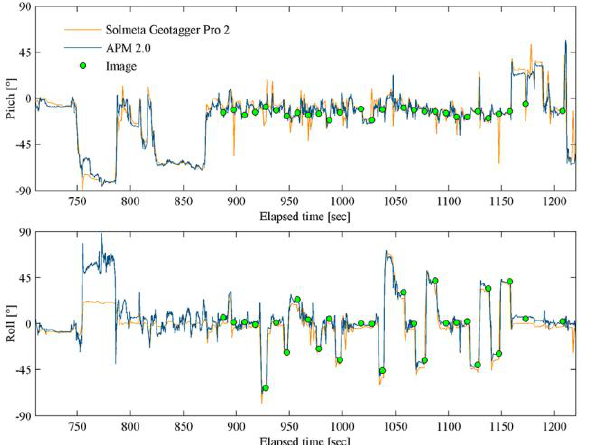
Figure 4. Pitch and roll angles obtained from the Solmeta Geotagger Pro 2 (orange), APM 2.0 (blue) and photographs (green dots)